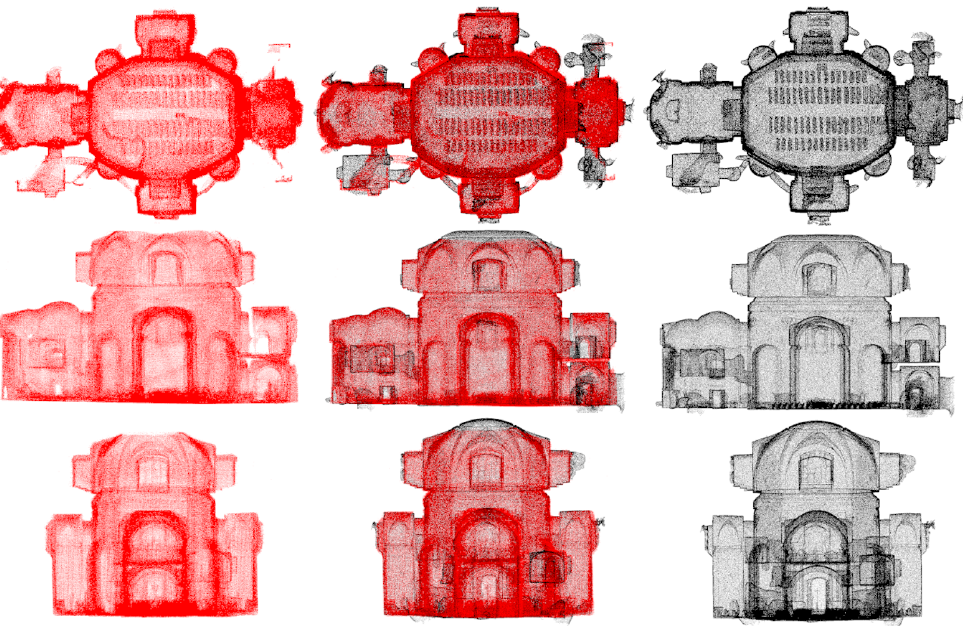
Figure 8. Comparison of the map with a resolution of 10cm built onboard the unmanned aerial vehicle during the documentation mission (red) with the ground truth map obtained from a terrestrial laser scanner (black). The figure shows the top, side, and front views respectively per rows of the church of St. Anne and St. Jacob the Great in Stará Voda in Libavá, Czech Republic. The mapping reached mean precision of µ = 14cm and standard deviation σ = 11cm using the Euclidean point-to-point